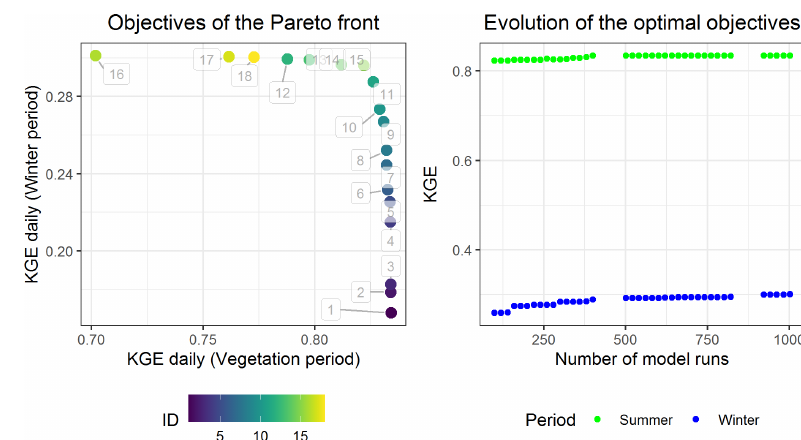
Figure C3. Resulted calibration Pareto fronts for Hetzdorf (chosen ID – 15).